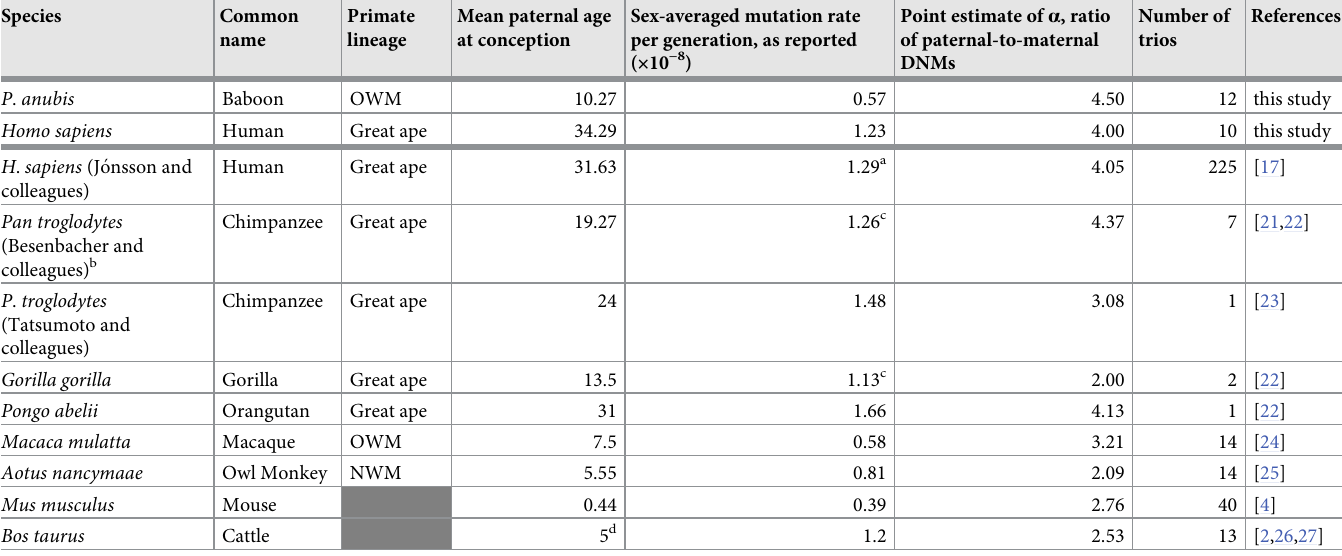
Table 1. Pedigree estimates of mutation rates and male-to-female DNM ratios in mammals.